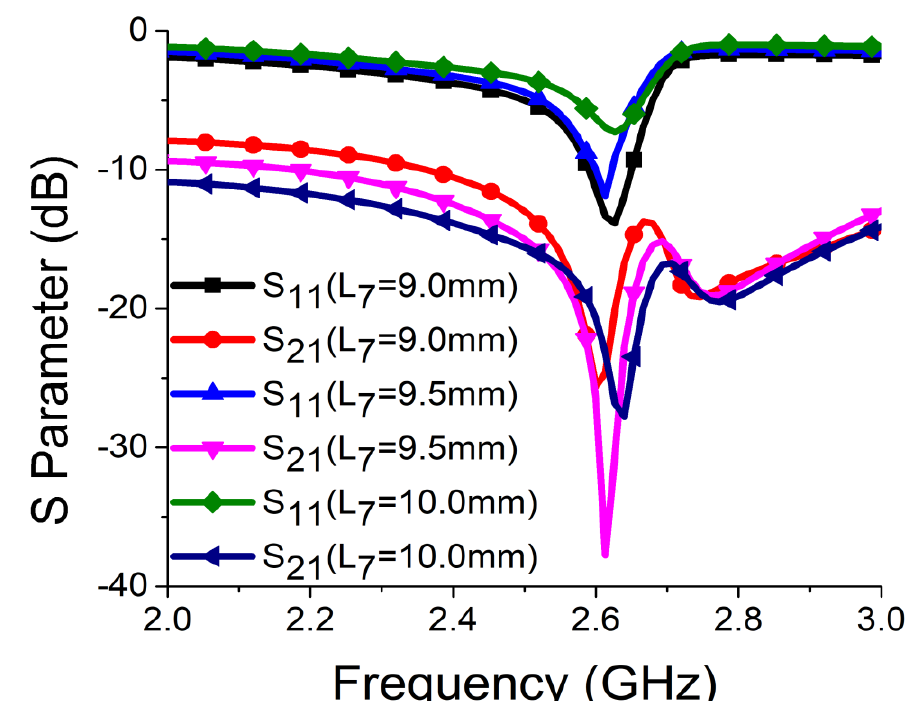
Figure 9. Effect of L 7 on resonance and isolation.